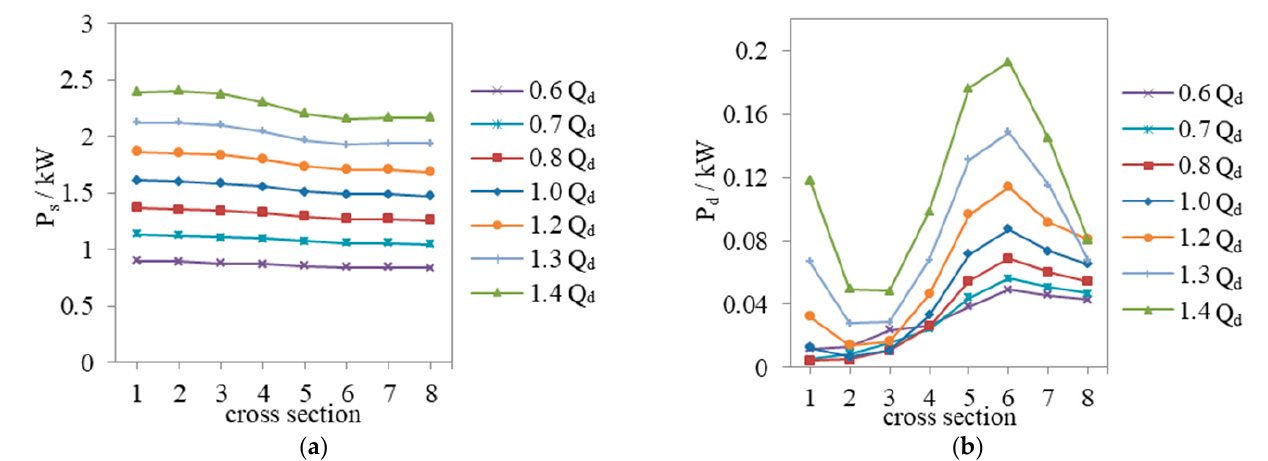
Figure 9. Static and dynamic pressure powers in each cross-section of the runner. ( a ) Static pressure power; ( b ) dynamic pressure power.